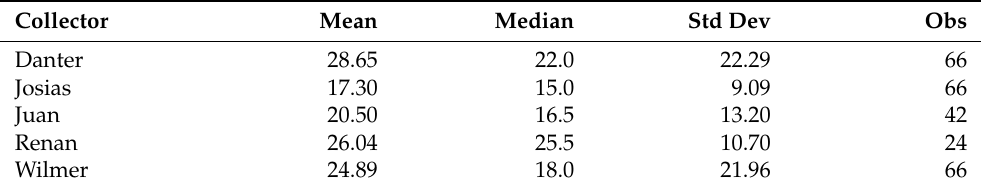
Table A4. Distribution of Observations by Collector and Treatment.